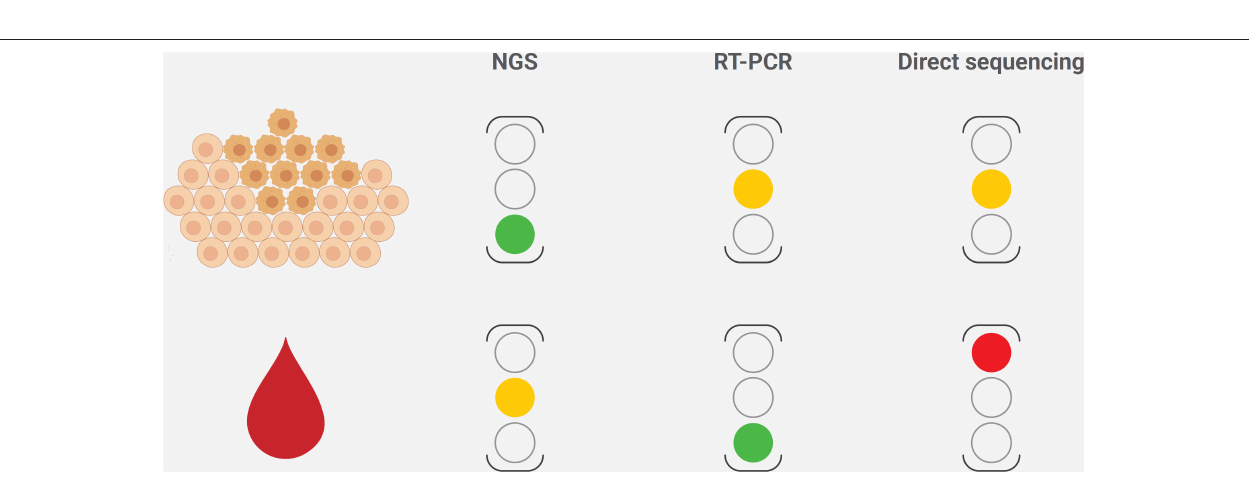
FIGURE 3 | Hierarchy diagram portraying the annotation and clinical actionability of PIK3CA mutations in ER + /HER2 − metastatic breast cancer. The connecting lines indicate the relationship between them.